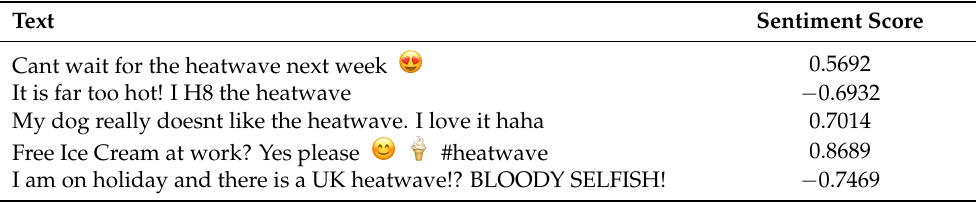
Table 3. Sentiment classified fictitious tweets using similar language to the dataset.